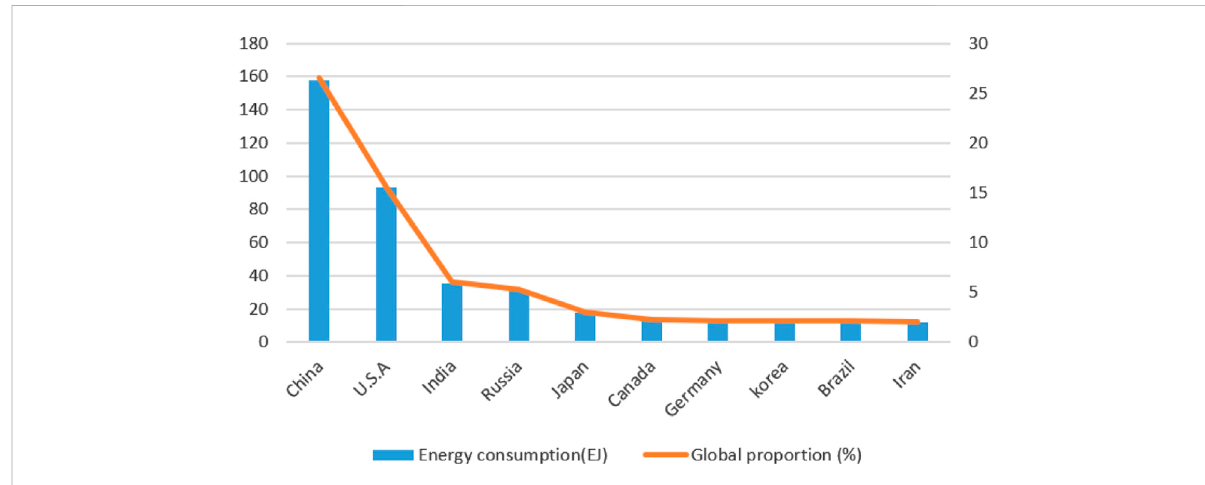
FIGURE 1 Top ten energy consuming countries in the world in 2021.